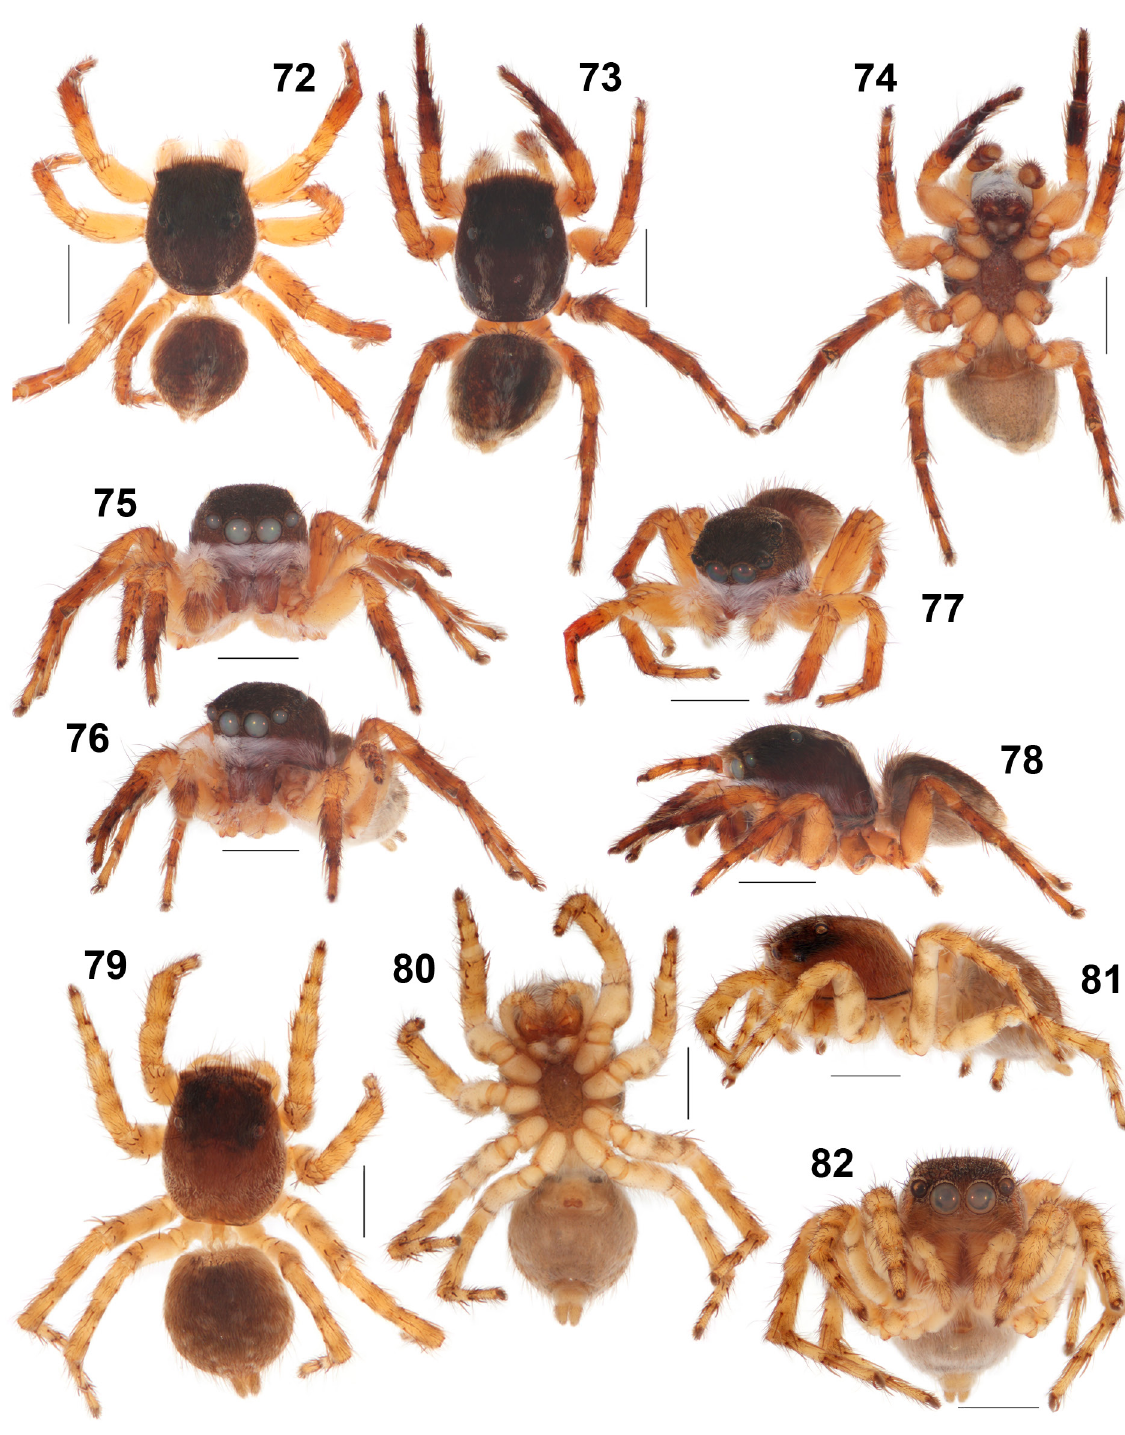
Figs 72–82. Manzuma jocquei (Azarkina, Wesołowska & Russell-Smith, 2011) gen. et comb. nov., ♂♂ from Gagnoa (73–76, 78) and Bouaké (72, 77), ♀ from Bouaké (79–82, NCA 2019/730), general appearance. Scale bars: 1